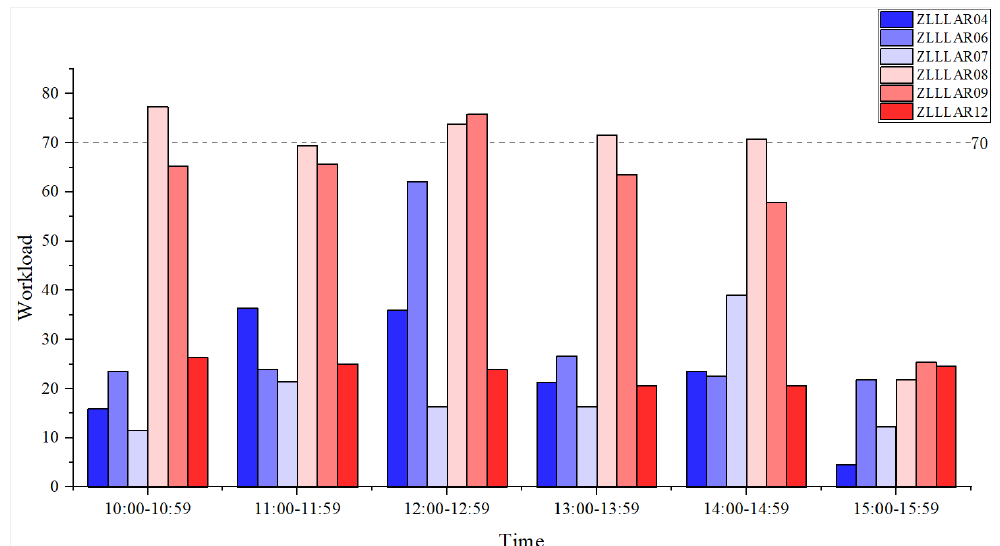
Figure 9. Lanzhou regional control airspace 8 June 2019 10:00 – 15:59 hourly workload forecast results for each sector.